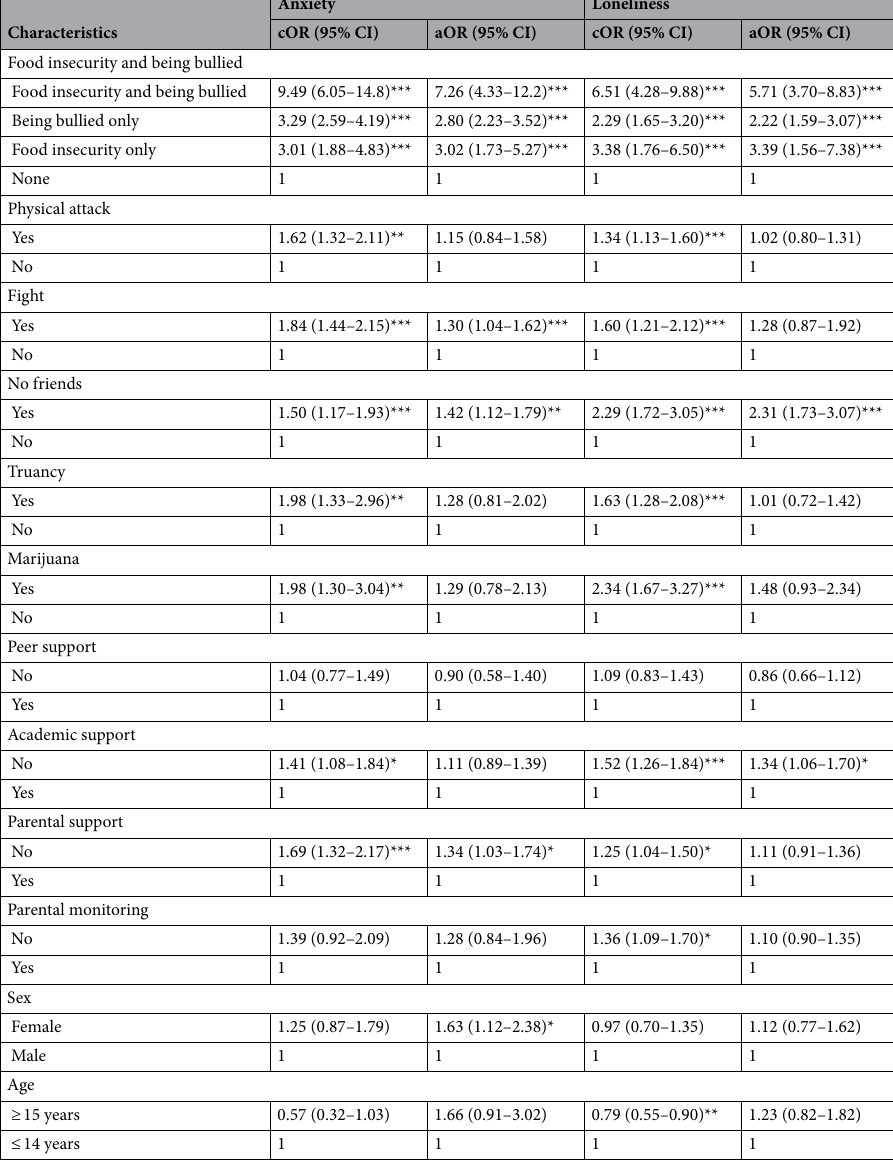
Table 4. Association of food insecurity and being bullied on anxiety and loneliness. cOR crude odds ratio, aOR adjusted odds ratio, CI confidence interval. *p < 0.05, **p < 0.01, ***p < 0.005. Adjusted for all other listed